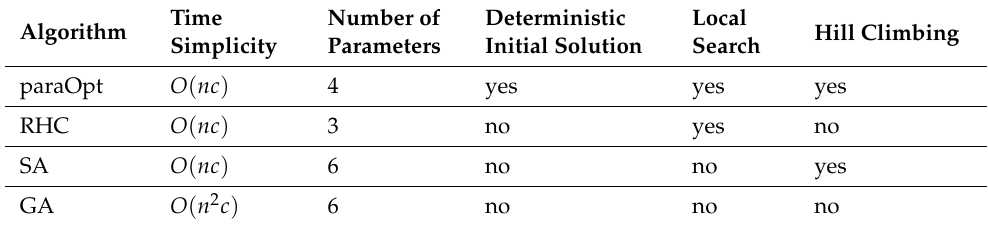
Table 1. Comparisons of four stochastic algorithms.